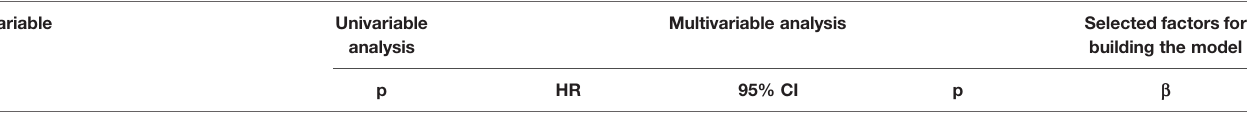
TABLE 2 | Univariate analysis, multivariate analysis, and factors for building the adaptive Elastic-Net Cox regression